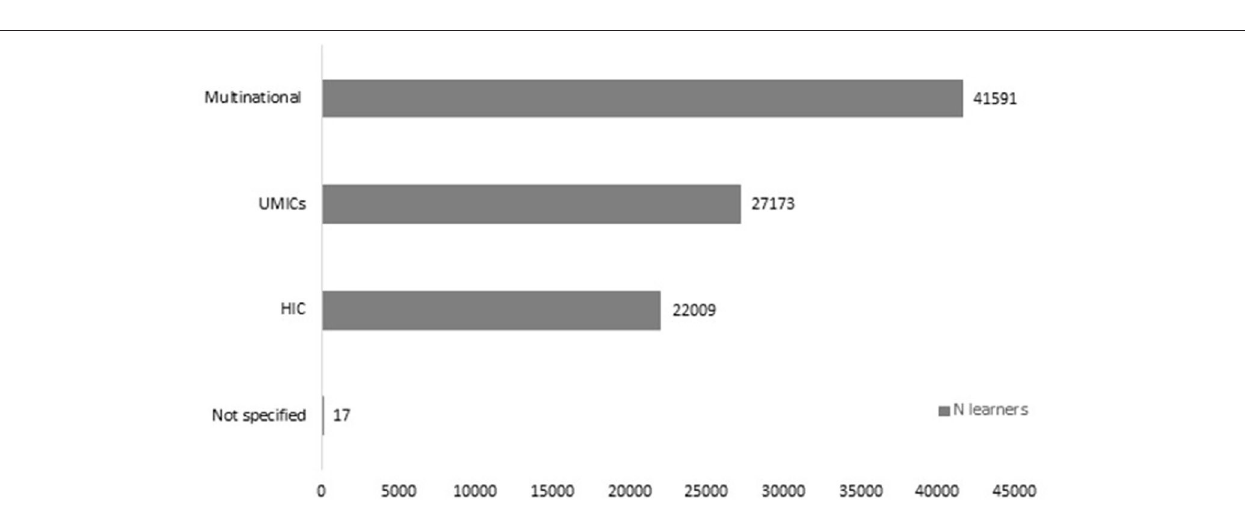
FIGURE 3 | Number of learners in MOOCs from different income